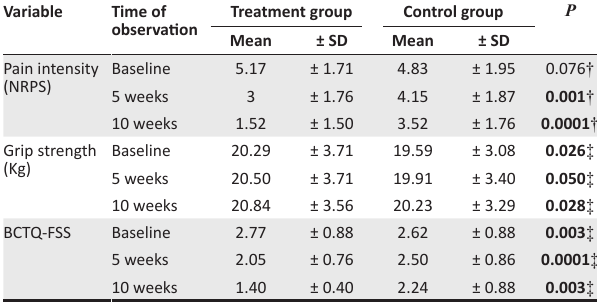
TABLE 3: Group means and standard deviation for pain intensity, grip strength and functional status; between-group comparison; and effect of therapy. Variable Time of